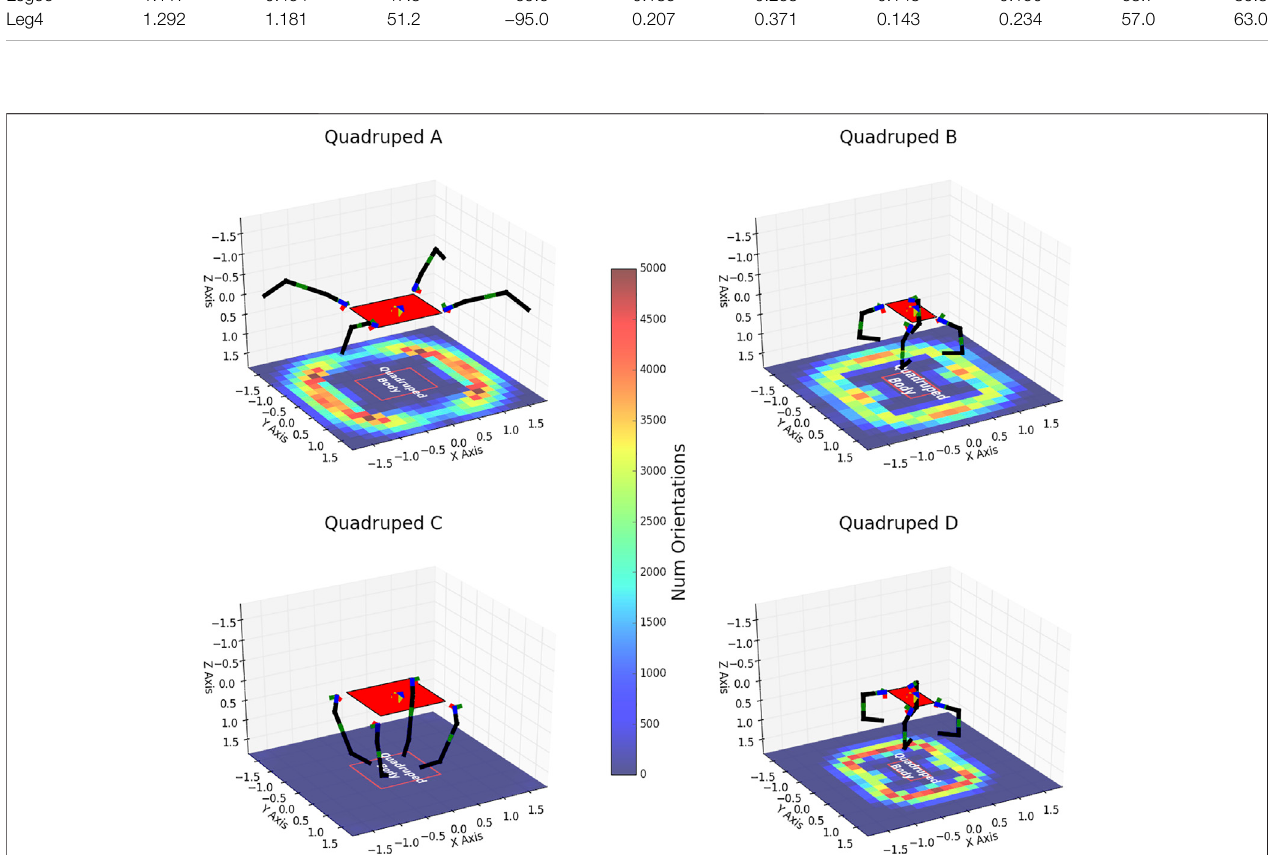
FIGURE 9 | Visualization of designs (A – D). Axis units are in meters. Rigid links are shown in black while the pneumatic joints are shown in green. The red outline on the heat map is a projection of the quadruped body (solid red) onto the x − y plane for visualization clarity.